Question: In one sentence, what is this figure communicating?
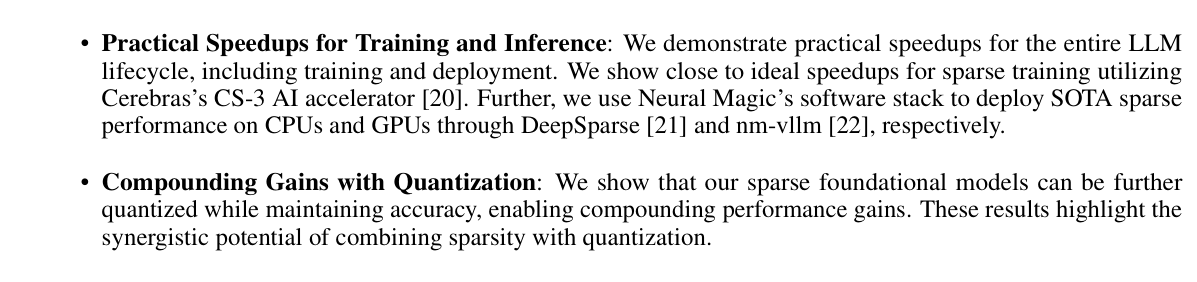
Answer: provides a high-level visualization of our results. Our sparse LLMs and efficient compute platforms offer dramatic speedups while preserving accuracy and creating a valuable stepping stone toward widely accessible and highly performant LLMs.